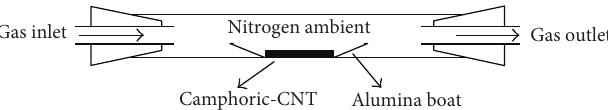
F 1: Schematic diagram of the apparatus that used for thermal annealing system.